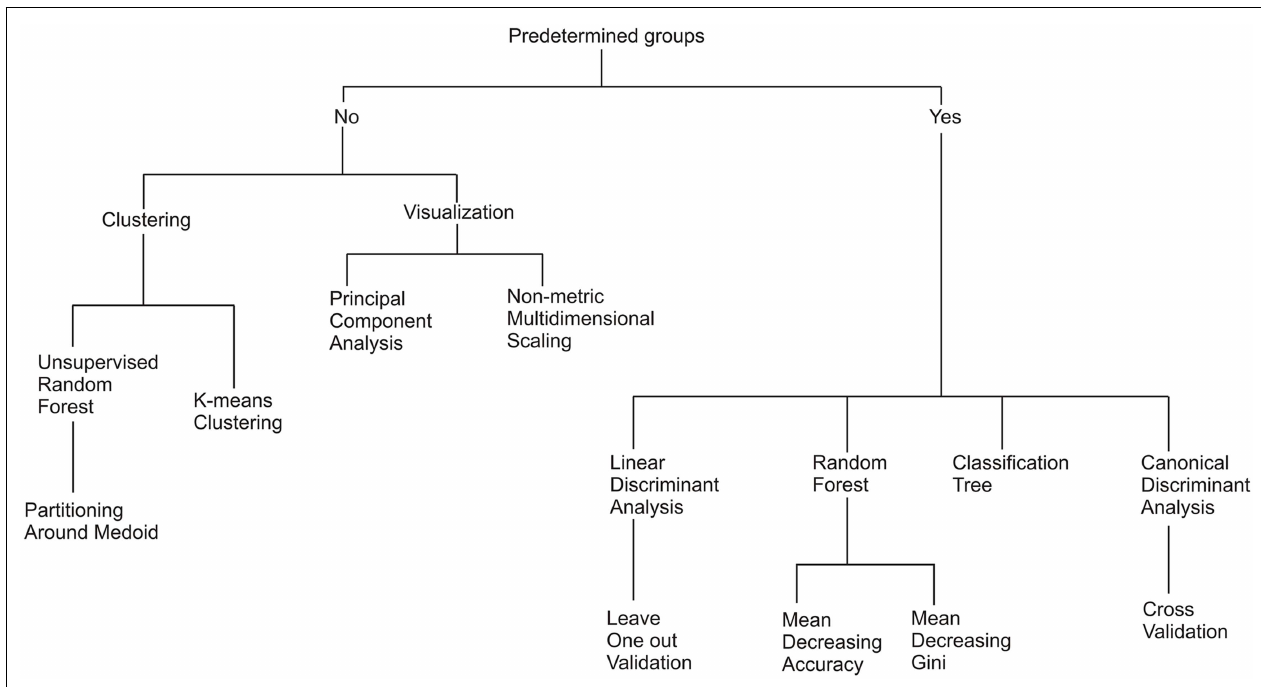
FIGURE 2 |A diagram of the relationship between the seven statistical methods evaluated.